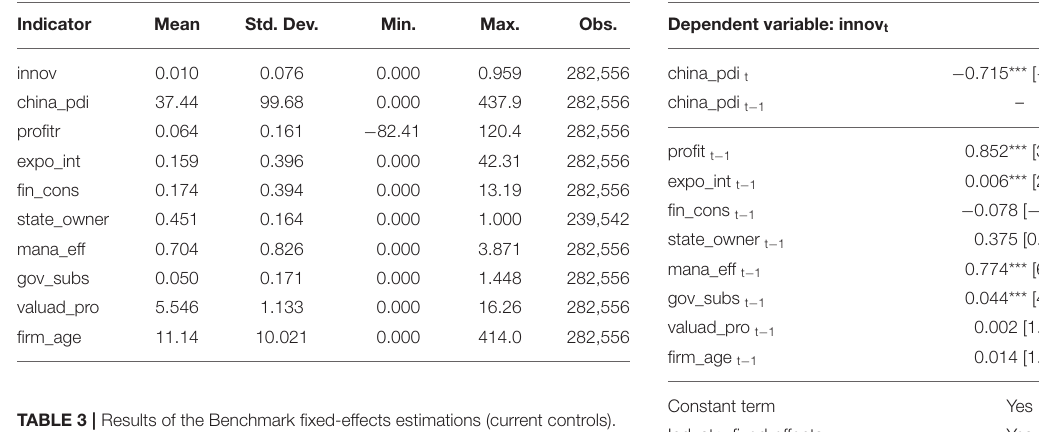
TABLE 4 | Results of the Benchmark fixed-effects estimations (lagged